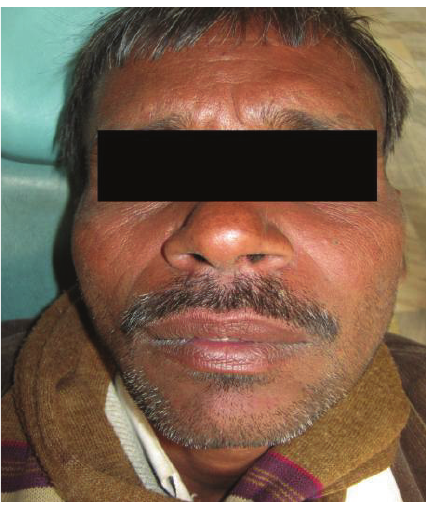
Figure 1: Profile view showing no cutaneous lesion.